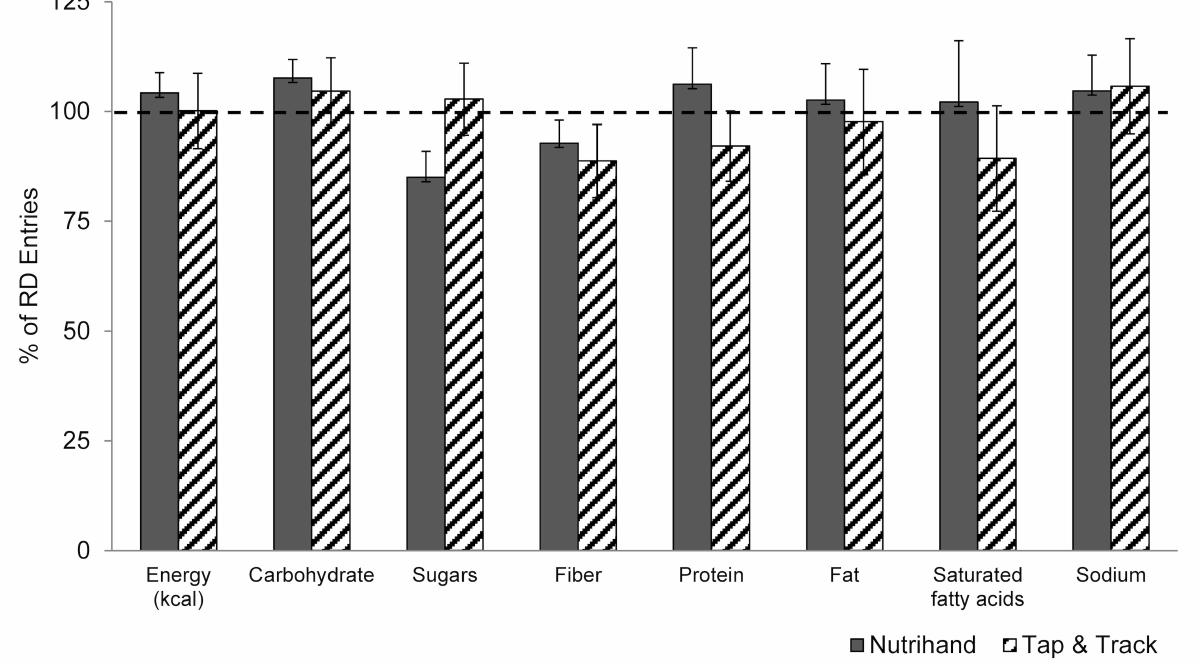
Figure 1. Percentage agreement between electronic methods of diet recording and dietitian-entered 3-day diet record (DR) comparing Nutrihand and Tap & Track to values obtained from Grand Forks Research Analysis of Nutrient Data (GRAND).